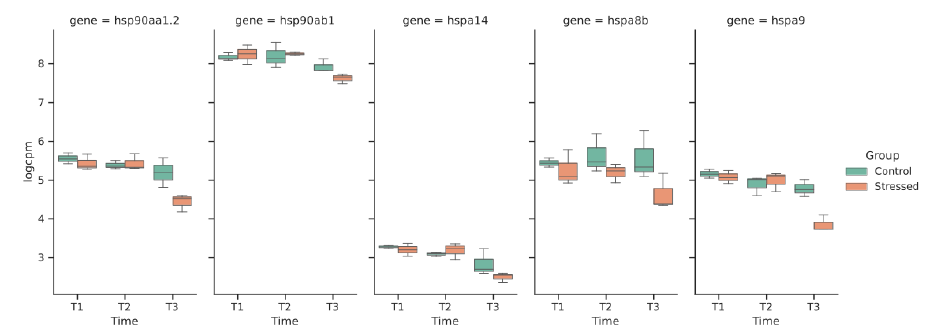
Figure 4. Expression levels in log(CPM) of the five HSPs differentially expressed across the entire